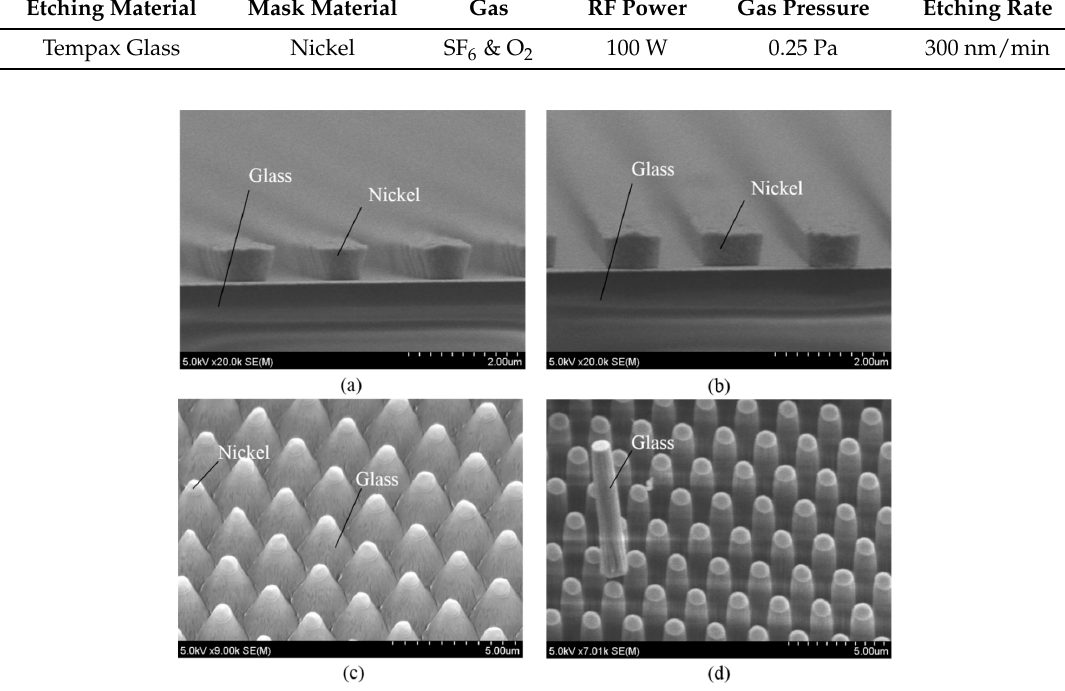
Figure 7. Experimental results. ( a ) Tilted mask profile (mask #1); ( b ) vertical mask profile (mask #2); ( c ) tapered cylinder profile; ( d ) vertical cylinder profile.